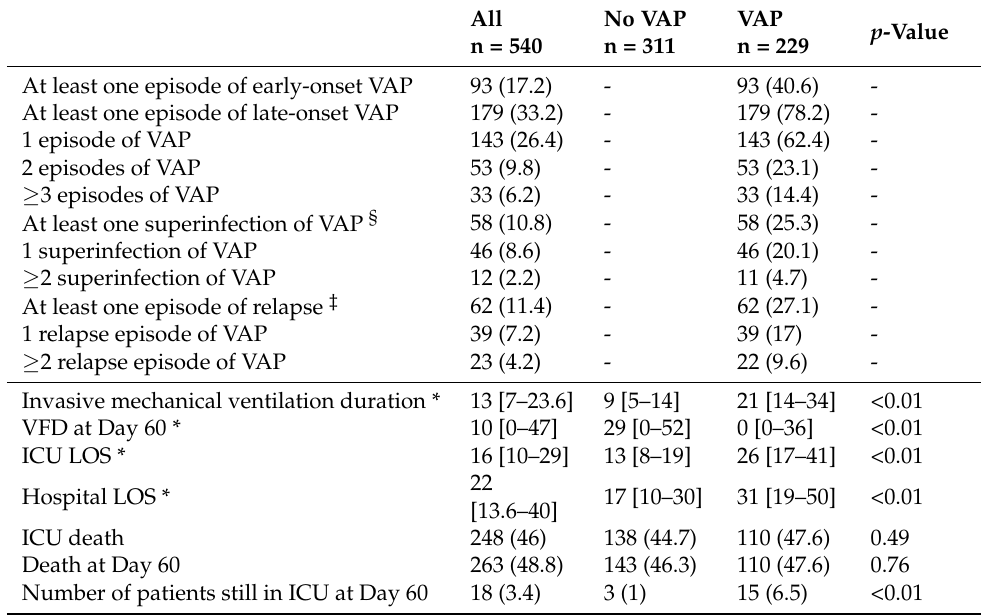
Table 2. Main outcomes according to the occurrence of ventilator-associated pneumonia (VAP).